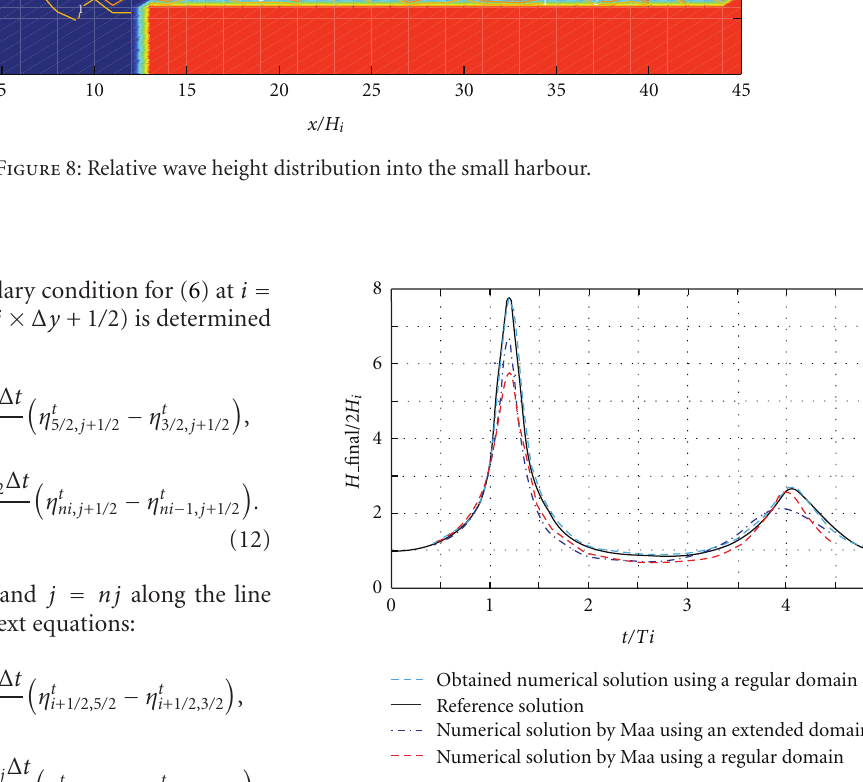
Figure 9: Time evolution of the wave height at the numerical